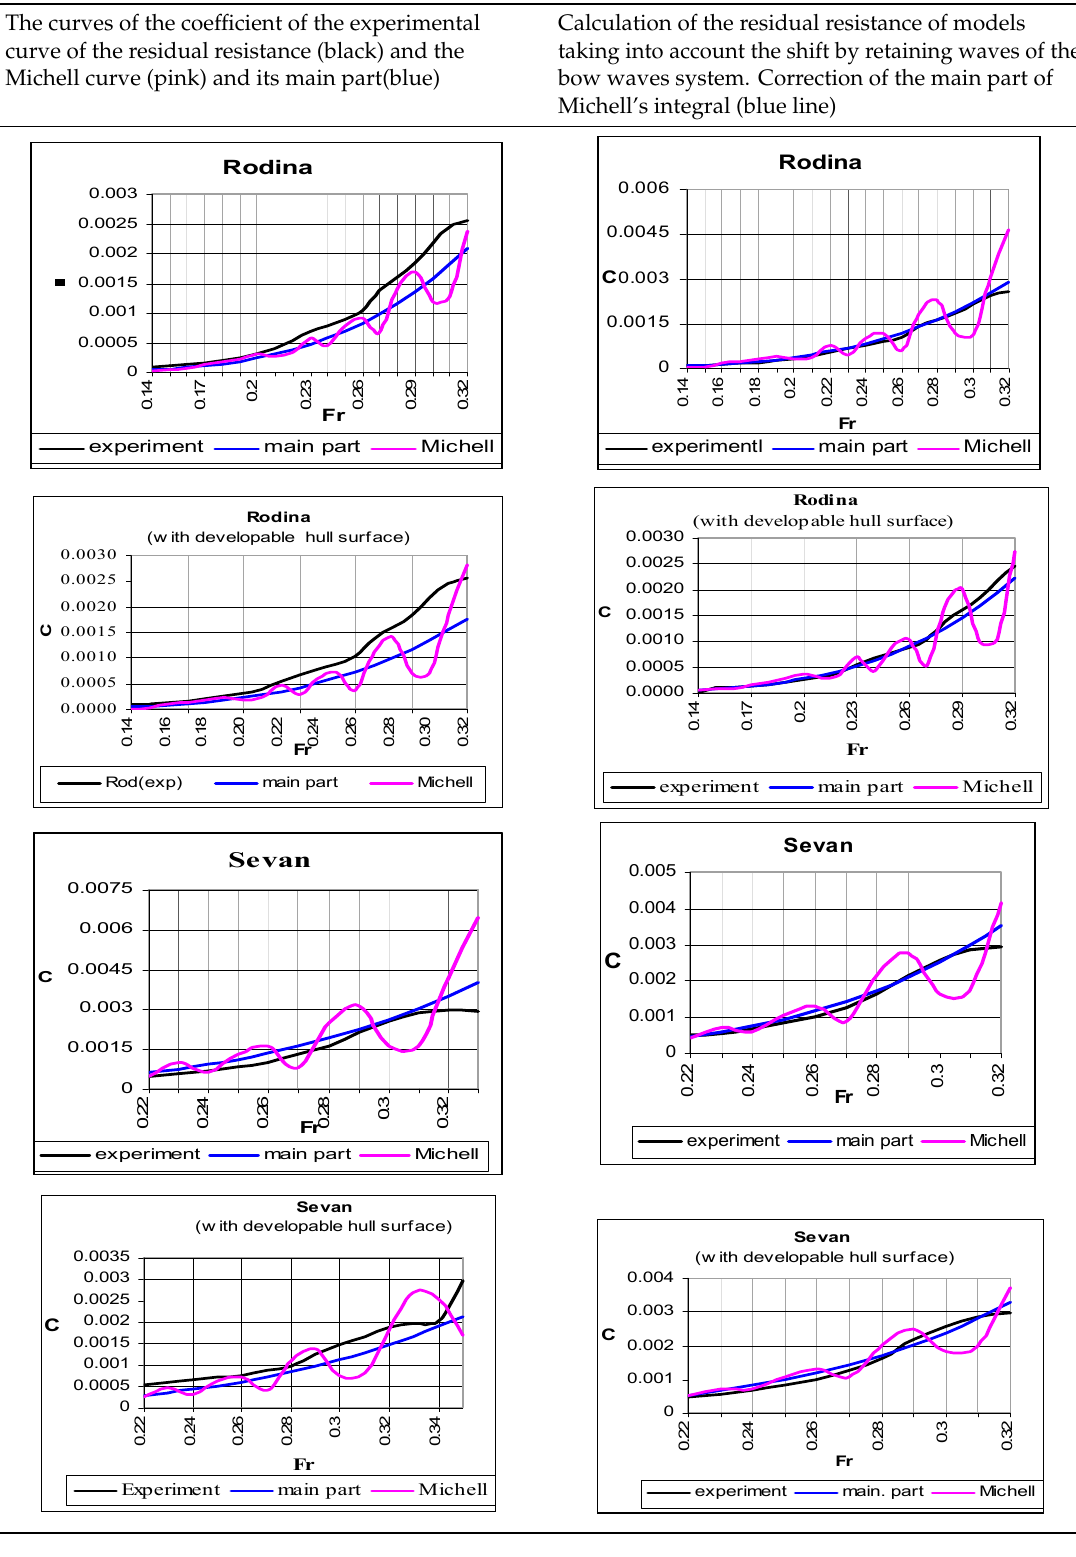
Table 8. Experiments and calculations wave and residual resistance of the river ships “Rodina” and “Sevan”. The curves of the coefficient of the experimental Calculation of the residual resistance of models curve of the residual resistance (black) and the taking into account the shift by retaining waves Michell curve (pink) and its main part(blue) of the bow waves system. Correction of the main part of Michell’s integral (blue line)